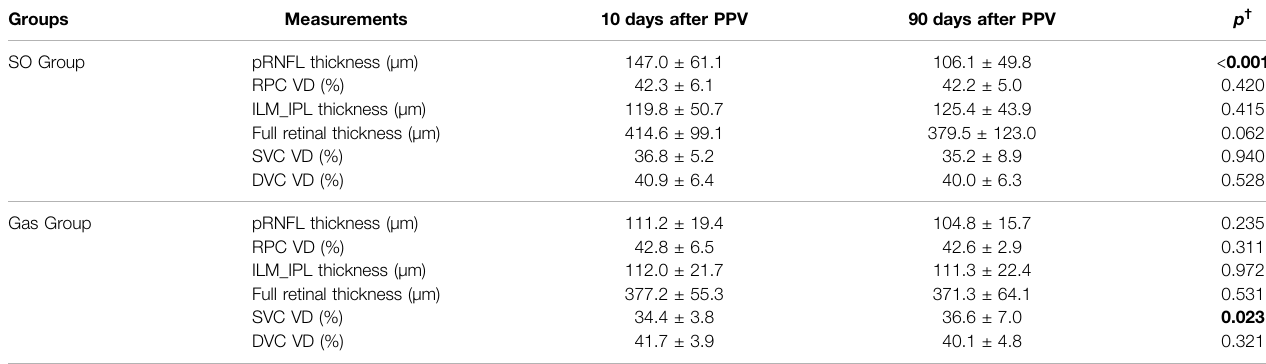
TABLE 2 | Longitudinal changes in evaluation indicators in the SO group and Gas group a